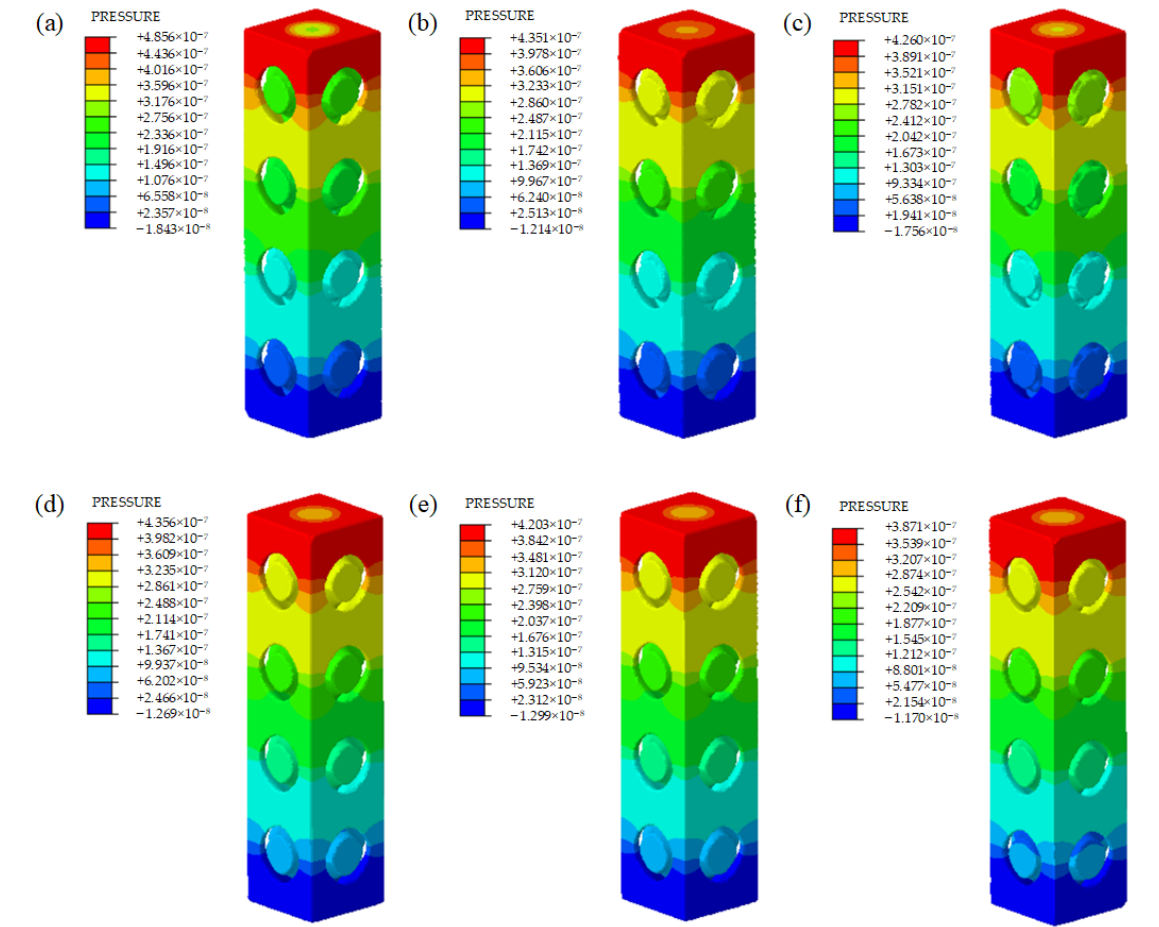
Figure 9. Pressure contours from CFD analysis of ( a ) P0.6A1, ( b ) P0.6B1, ( c ) P0.6C1, ( d ) P0.6A2, ( e ) P0.6B2, and ( f ) P0.6C2.